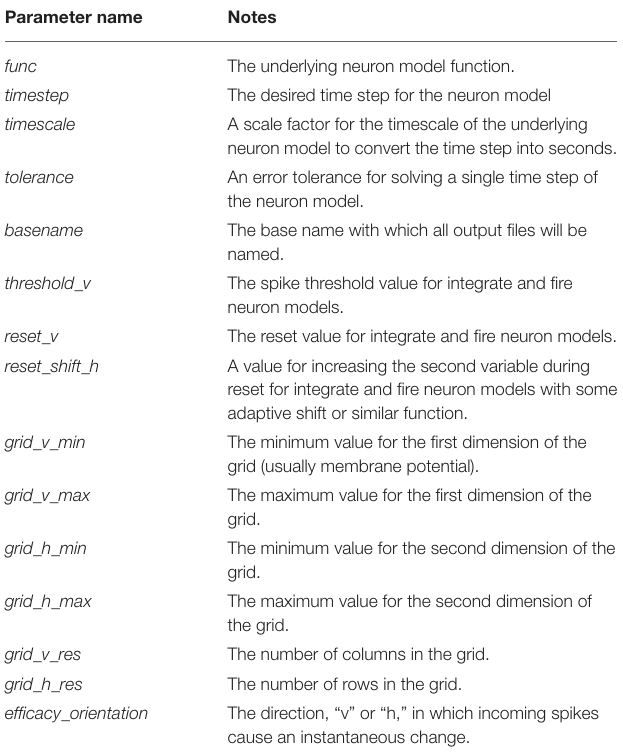
TABLE 1 | Parameters for the grid_generate.generate